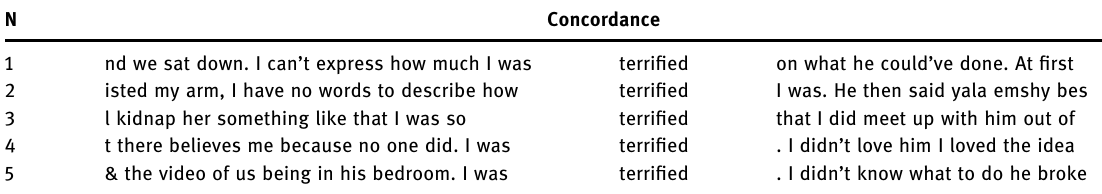
Table 26: Concordance lines for terri fi ed N Concordance